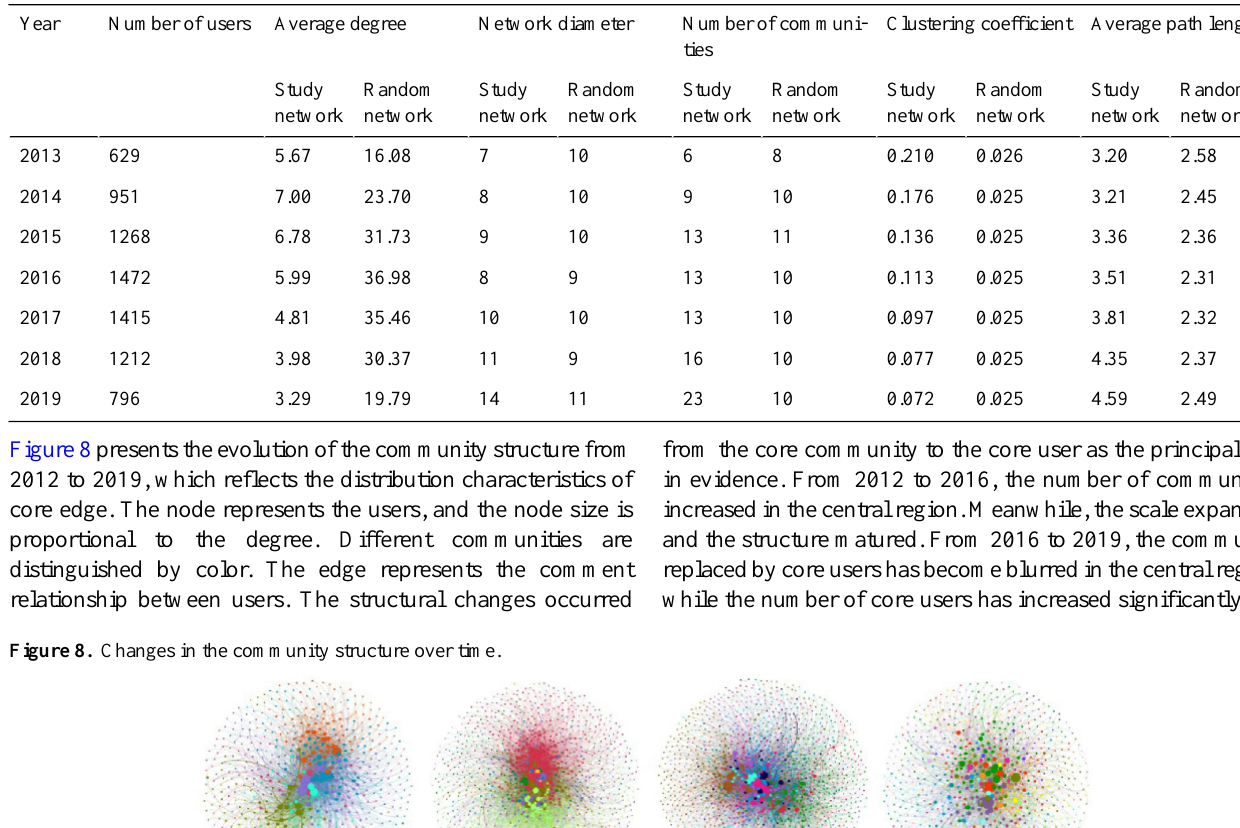
Table 3. Basic statistics for the social network analysis, compared with those of a random network.